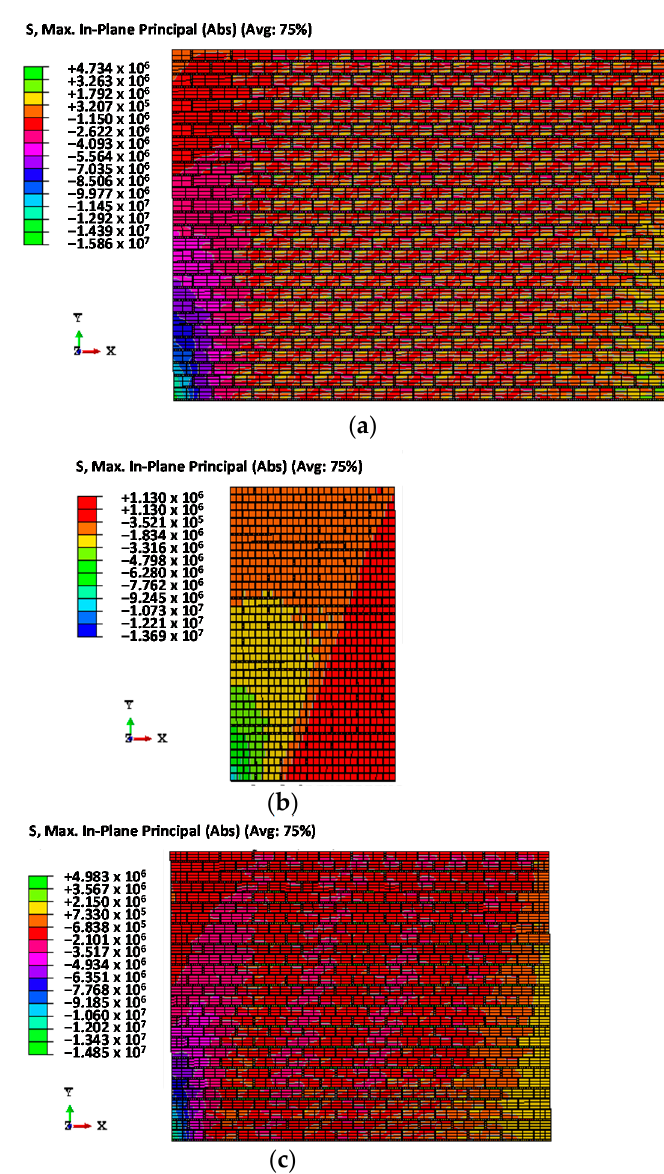
Figure 9. URM wall simulations in ABAQUS for validation of the various failure mechanisms: ( a ) stocky, ( b ) slender and ( c ) square.